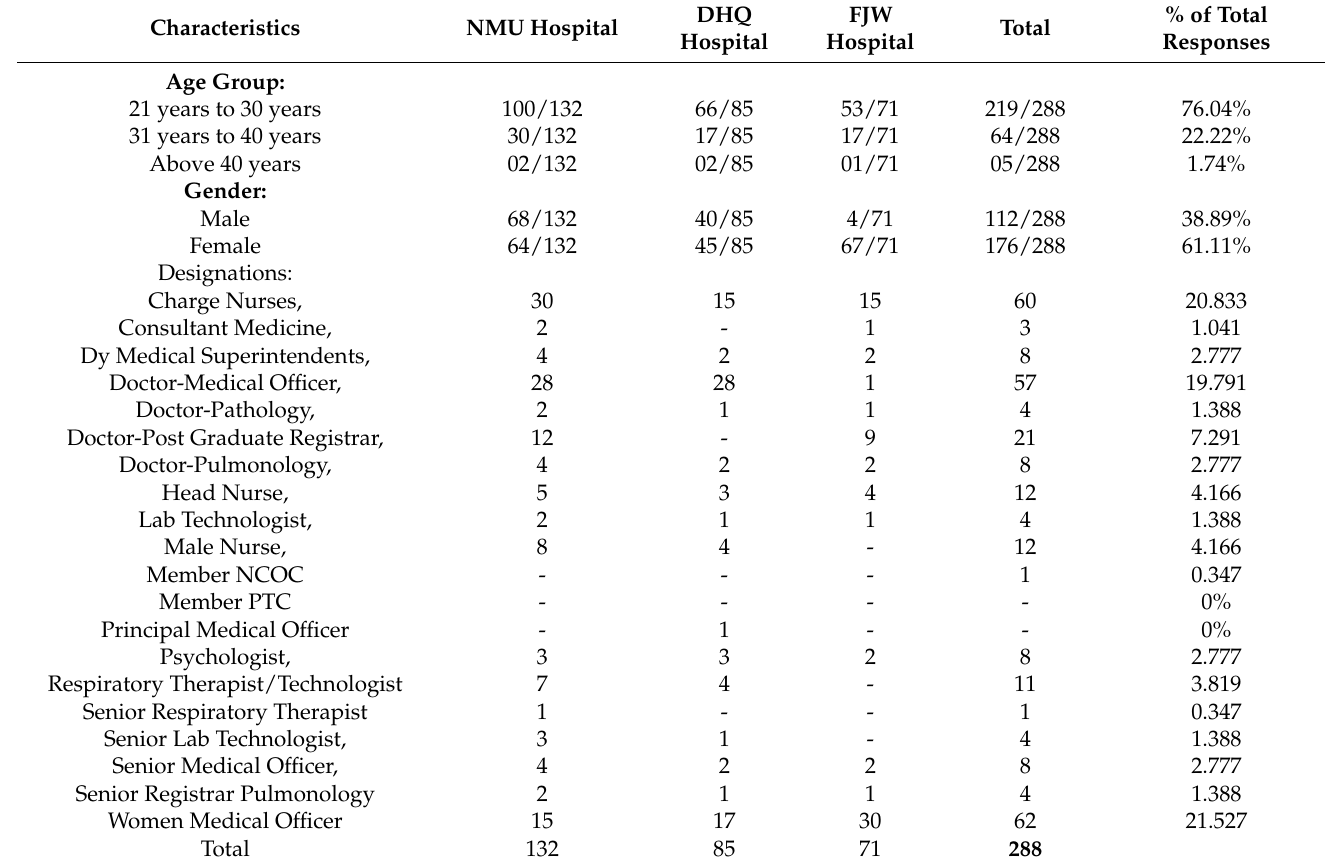
Table A3. Demographic Information of Survey